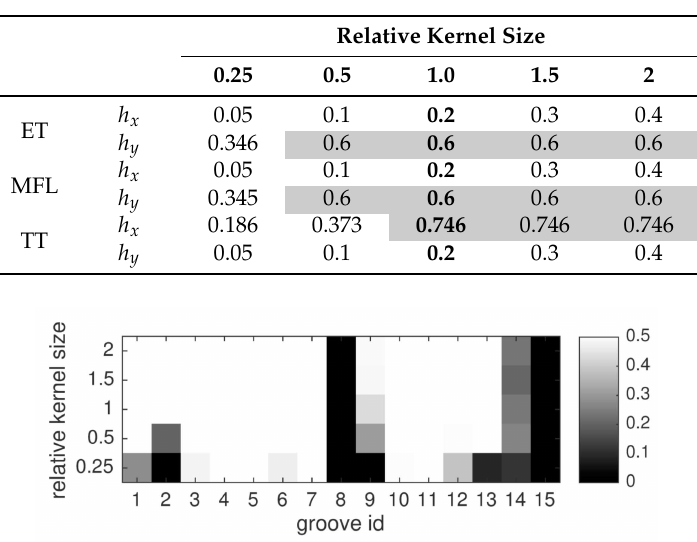
Figure 12. Evaluation of different kernel sizes, for the product fusion rule. For each groove and fusion method, the AUC-PR-0.5 is shown in shades of